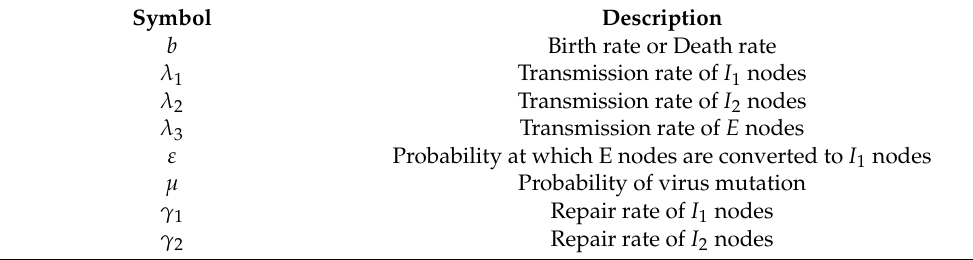
Table 1. The parameters of the model.